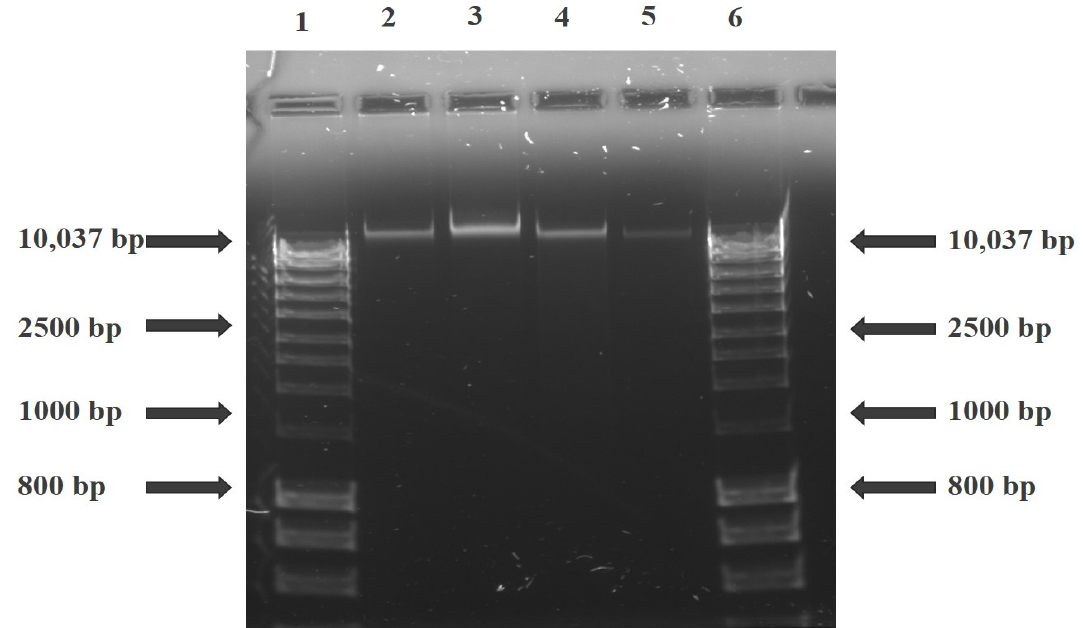
Figure 2. Agarose gel electrophoresis of MCF-7/DOX cell extracted DNA after ZnPcS4—PDT treatment. Lanes 1 and 6 are loaded with DNA hyper-ladder, and Lanes 2, 3, 4, and 5 with the untreated control, 5, 10, and 20 J/cm 2 fluencies, respec- tively.